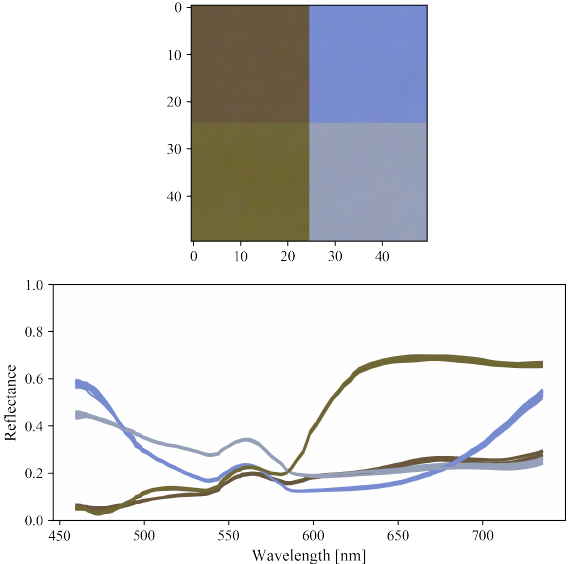
Figure 2. Illustration of the training dataset. Above there is ”RGB” presentation of the dataset in the spatial dimensions. Below there are sample reflectance spectra from each class.